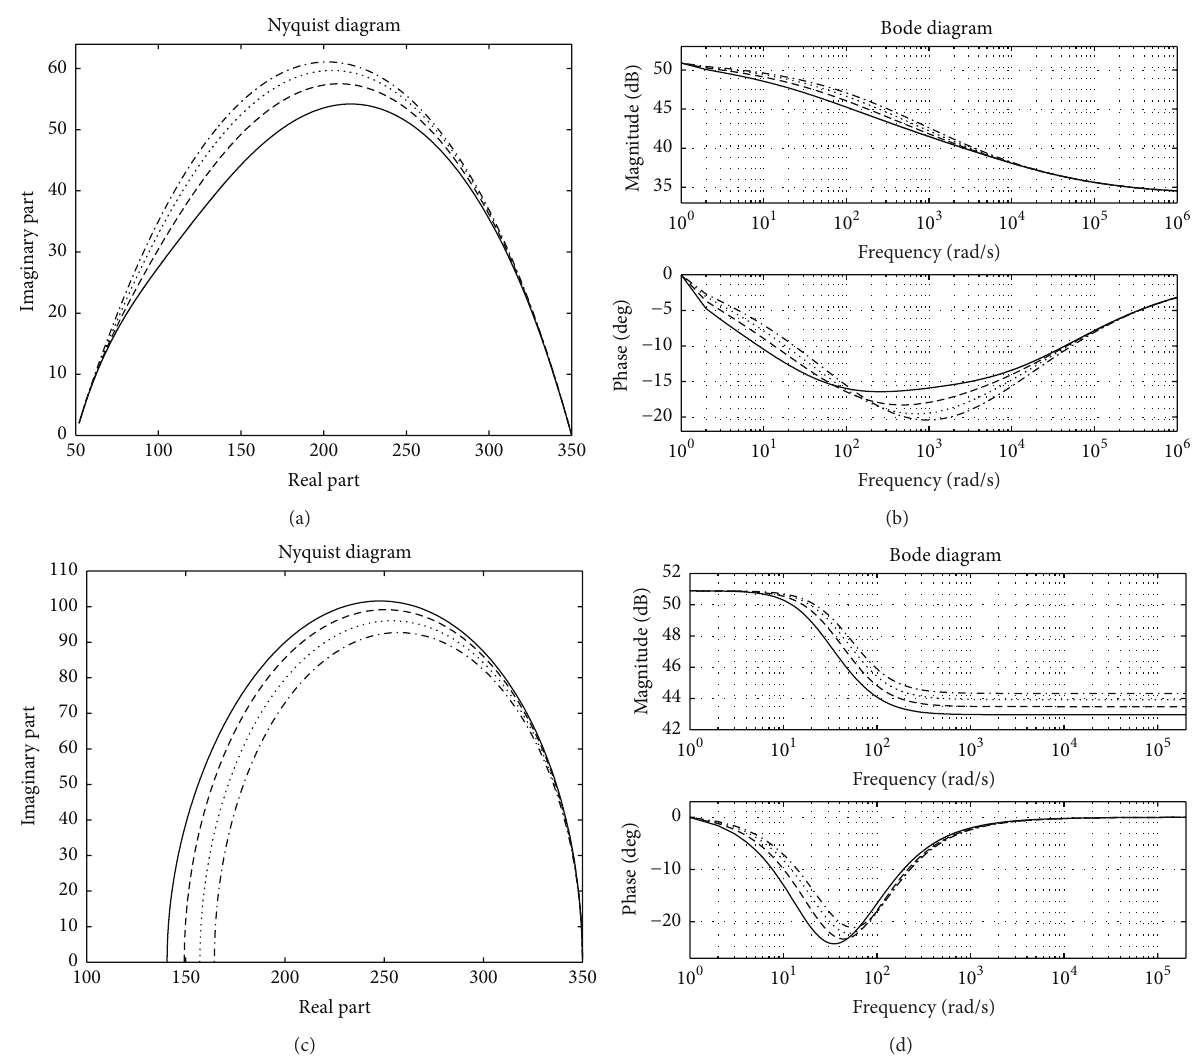
Figure 7: Nyquist and Bode diagram for the heterogeneous reaction model, Caputo approach in (a) and (b) and Caputo-Fabrizio approach in (c) and (d). For (a) and (b), 𝑅 1 = 50Ω , R 2 = 100 Ω , 𝑅 3 = 200 Ω , 𝐶 1 = 1 −3 F, 𝐶 2 = 1 −2 F (solid line), 𝐶 2 = 3 −3 F (dash line), 𝐶 2 = 3 −3 F (dot line), and 𝐶 2 = 3 −4 F (dash-dot line). For the capacitor 𝐶 1 , 𝛾 = 1/2 ; for the capacitor 𝐶 2 , 𝛽 = 1/2 . For (c) and (d), 𝑅 1 = 50Ω , 𝑅 2 = 100 Ω , = 200 Ω , 𝐶 = 1 −3 F, 𝐶 = 1 −2 F (solid line), 𝐶 = 3 −3 F (dash line), 𝐶 = 3 −3 F (dot line), and 𝐶 = 3 −4 F (dash-dot line). For the capacitor 𝑅 3 1 2 2 2 2 𝛾 = 1/2 ; for the capacitor 𝐶 𝛽 = 1/2 . 𝐶 1 , 2 ,